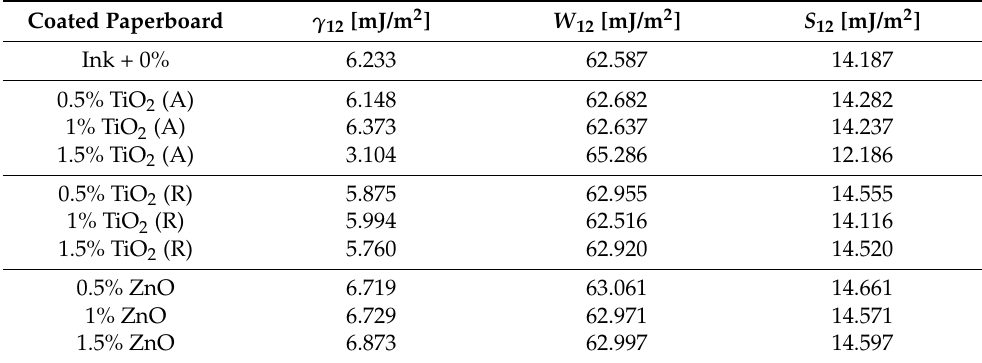
Table 4. Adhesion parameters on coated